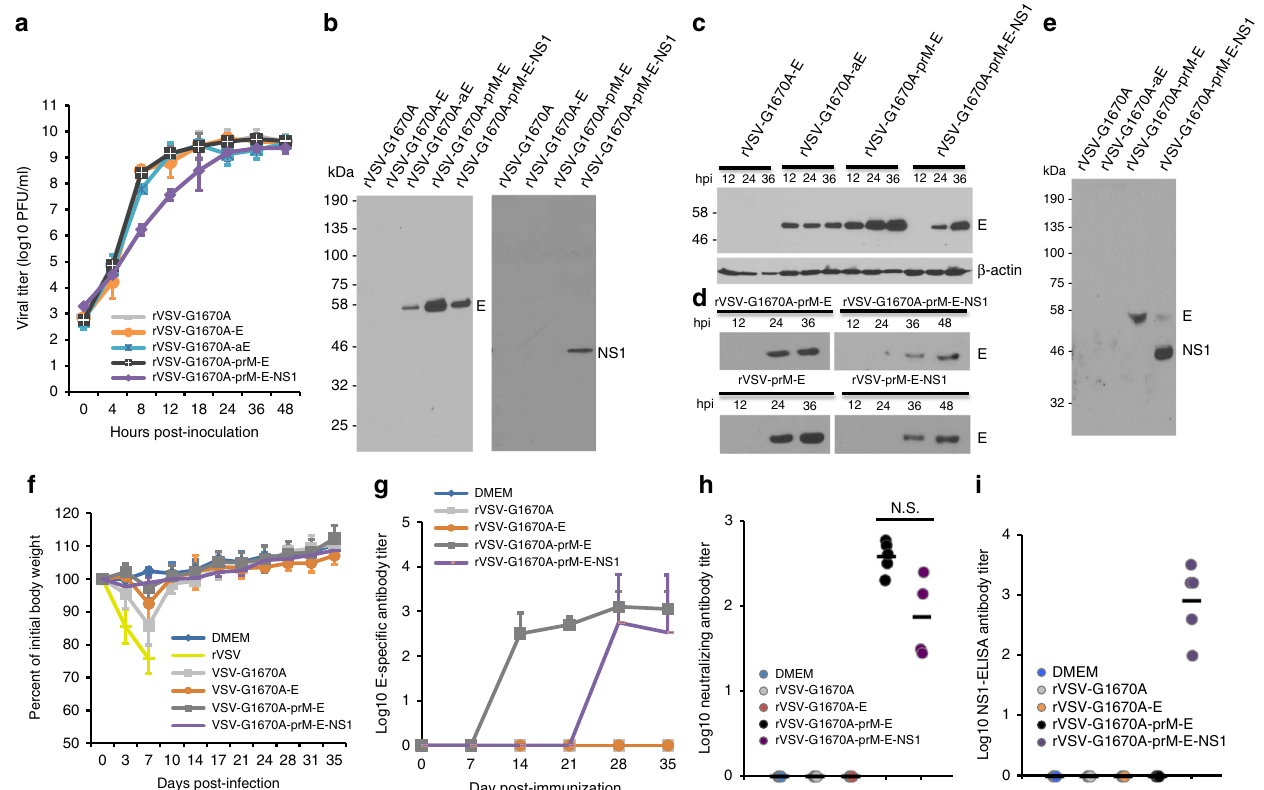
Fig. 2 ZIKV antigen expression and antibody response by MTase-defective rVSV (mtdVSV) vector. a Single-step growth curve of mtdVSVs. Con fl uent BSRT7 cells were infected with individual viruses at an MOI of 3.0. After 1 h of incubation, the inoculum was removed, the cells were washed with DMEM, and fresh medium (containing 2% fetal bovine serum) was added, followed by incubation at 37 °C. Samples of supernatant were harvested at the indicated intervals over a 48-h time period, and the viral titer was determined by plaque assay. Data are the GMT of three independent experiments ± standard deviation. b Expression of ZIKV antigens by the mtdVSV in cell lysates. BSRT7 cells were infected with each recombinant virus at an MOI of 3.0. At 24 h post-infection, cell lysates were harvested and analyzed by western blot using antibody against ZIKV E or NS1 protein. c Kinetics of ZIKV E protein expression in cell lysates. Top panel: BSRT7 cells were infected with each recombinant virus at an MOI of 3.0. At 12, 24, and 36 h post-infection, cell lysates were harvested and analyzed by western blot using antibody against ZIKV E protein. Bottom panel: Equal amounts of total cytoplasmic lysate were blotted with anti- β -actin antibody. d Kinetics of ZIKV E protein release into cell culture supernatants. Cell culture supernatants were harvested from virus-infected cells at the indicated time points, and 10 µ l of supernatant was analyzed by western blot using E-speci fi c antibody. e ZIKV NS1 protein released into the cell culture supernatant. Cell culture supernatants were harvested from virus-infected cells at 36 h post-infection, and 10 µ l of supernatant was analyzed by western blot using ZIKV serum antibody. f Dynamics of mouse body weight after inoculation with mtdVSV. Five six-week-old female BALB/c mice in each group were intranasally inoculated with DMEM or 10 6 PFU of rVSV or mtdVSV expressing ZIKV antigens. The body weight for each mouse was evaluated at indicated time points. The average body weights of fi ve mice were shown. All mice in rVSV group were dead and euthanized at day 7. g Kinetics of ZIKV speci fi c antibody induced by mtdVSV expressing ZIKV antigen. Serum samples were collected weekly and analyzed by ELISA for ZIKV-speci fi c serum IgG Ab. The titers are expressed as the GMT of fi ve mice ± standard deviation. h ZIKV speci fi c neutralizing antibody titer at week 5 post-inoculation. i ZIKV NS1-speci fi c antibody detected by ELISA at week 5 post-inoculation. The western blot gels presented are a representative of three independent experiments. Mouse body weights are mean of fi ve mice ± standard